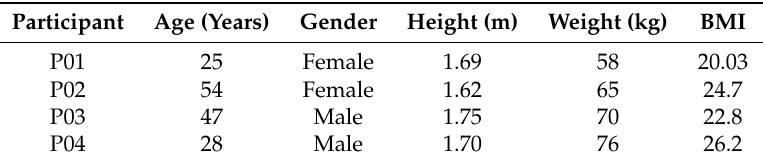
Table 1. Participant Summary